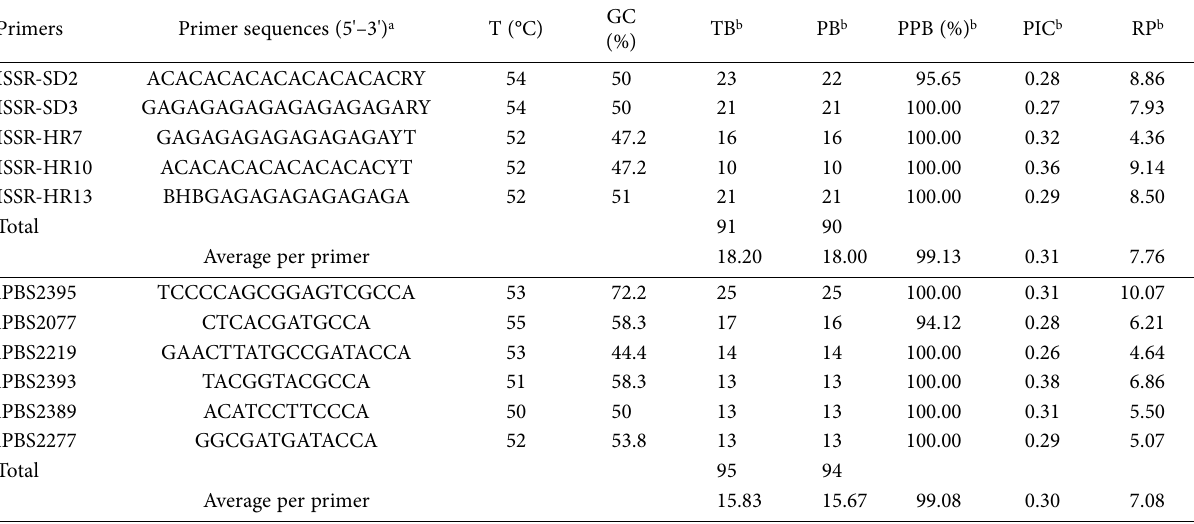
Table 2. ISSR and iPBS markers used in this study and their characteristics.